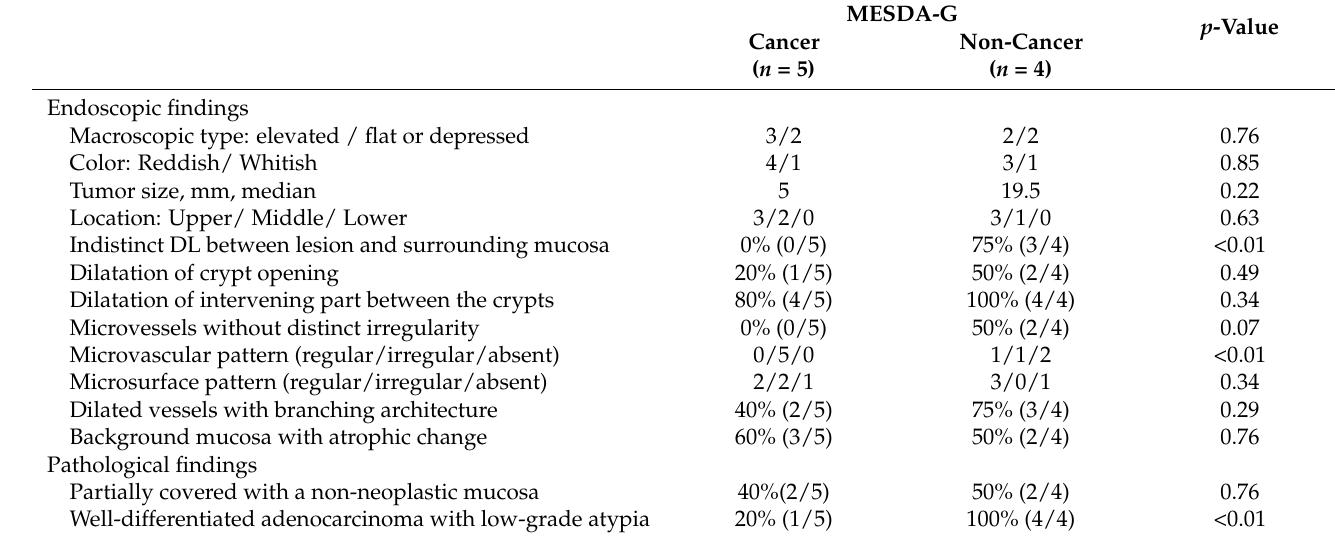
Table 2. Endoscopic and pathological findings of GA-FGM according to diagnosis of